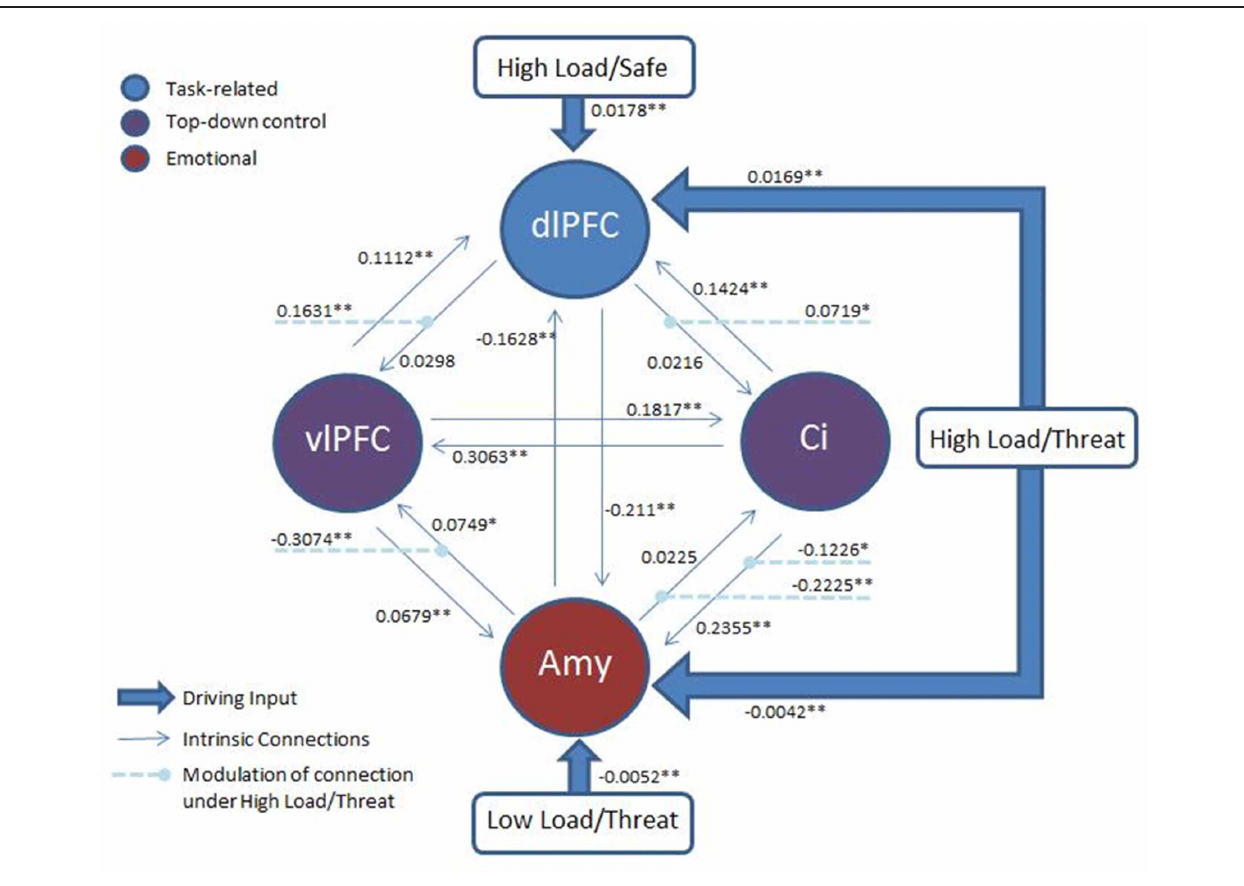
conditions to the right dlPFC. Modulation of connections by High Load/Threat are also displayed. Full connectivity was permitted between all nodes. Average parameter estimates for each intrinsic connection, driving input and modulation are displayed. ∗ p < 0 . 05 (two-tailed; uncorrected). ∗∗ p < 0 . 05(two-tailed, Bonferonni correction